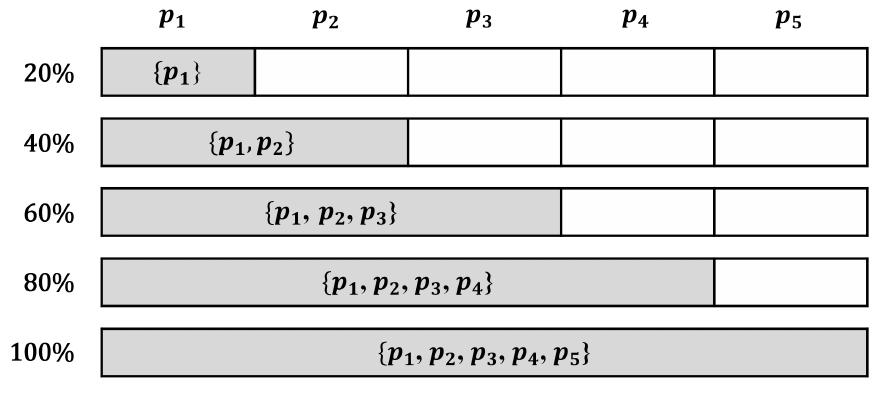
Figure 6. Five training set